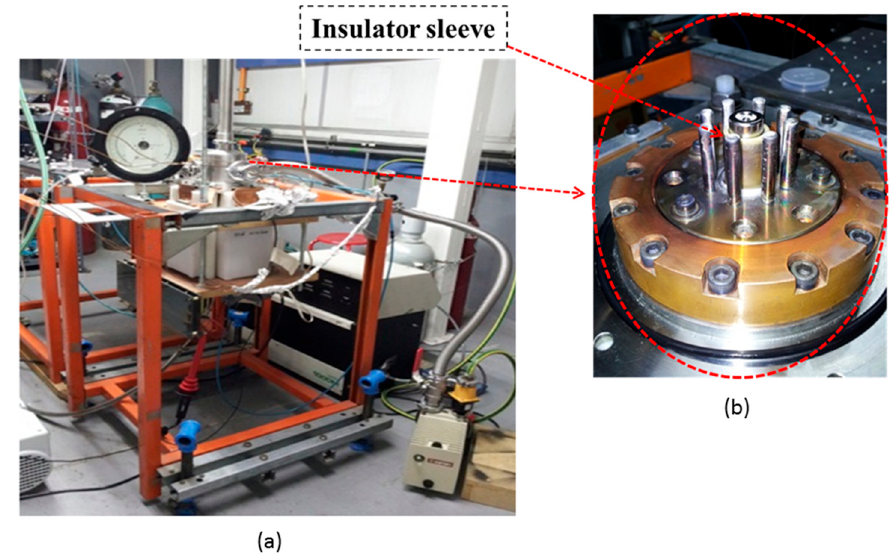
Figure 1. ( a ) Image of the PF-400J discharge, with the vacuum chamber on top and the capacitor bank at the center of the frame. The frame is approximately 50 × 60 × 90 cm; ( b ) Coaxial electrode assembly. Anode is at the center; the insulator sleeve covering most of the electrode; cathode bars on the outside.